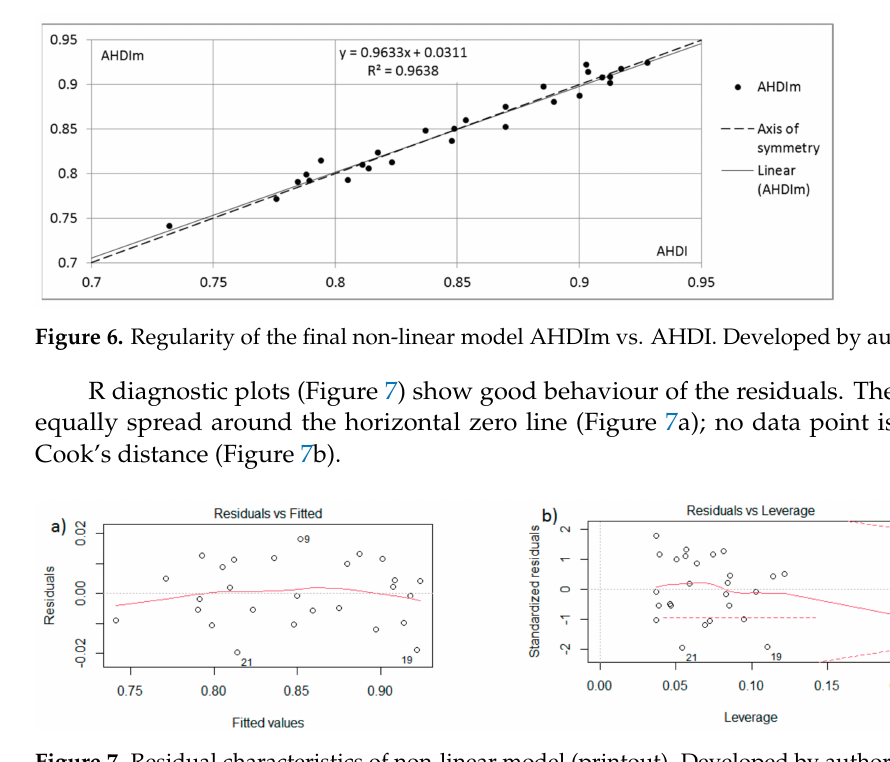
Figure 7. Residual characteristics of non-linear model (printout). Developed by